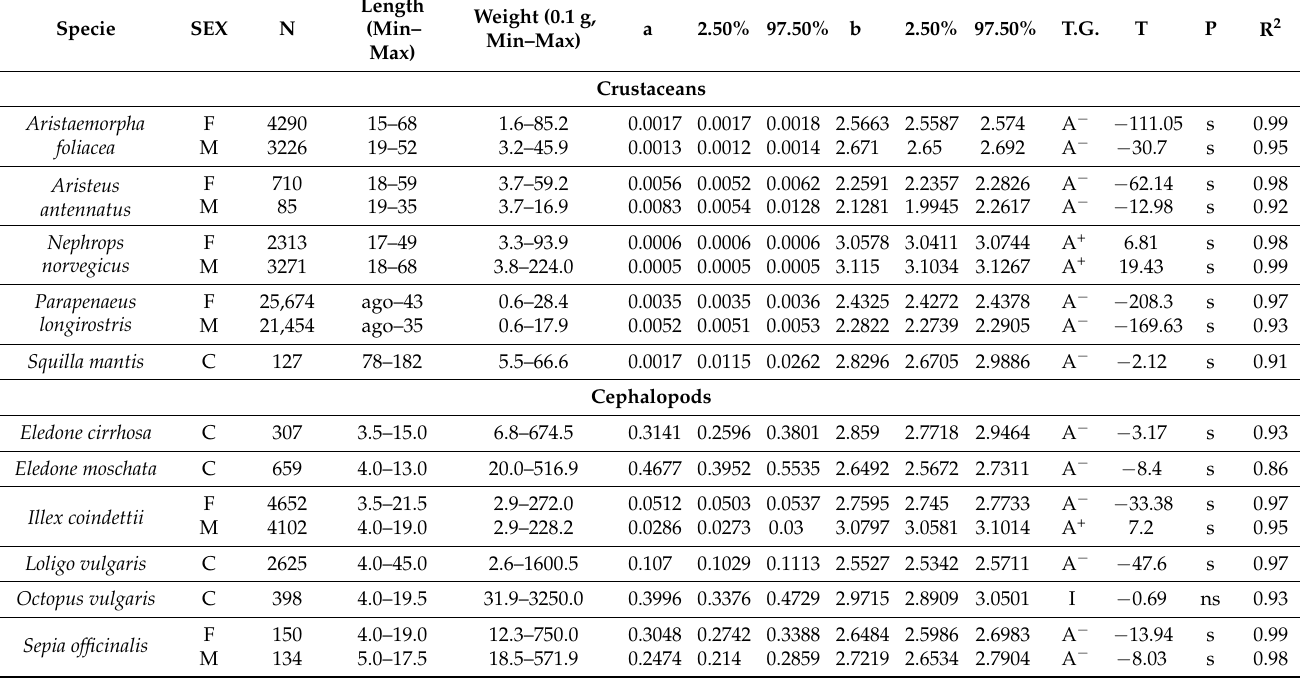
Table 1. Length-Weight relationships of 52 species from the South of Sicily. The species in bold type are those firstly reported in the Strait of Sicily. Length is reported in mm for crustaceans and in cm for cephalopods, bony and cartilaginous fishes. Weight is reported at 0.1 grams’ accuracies for crustaceans and cephalopods and at grams for bony and cartilaginous fishes. N: sample